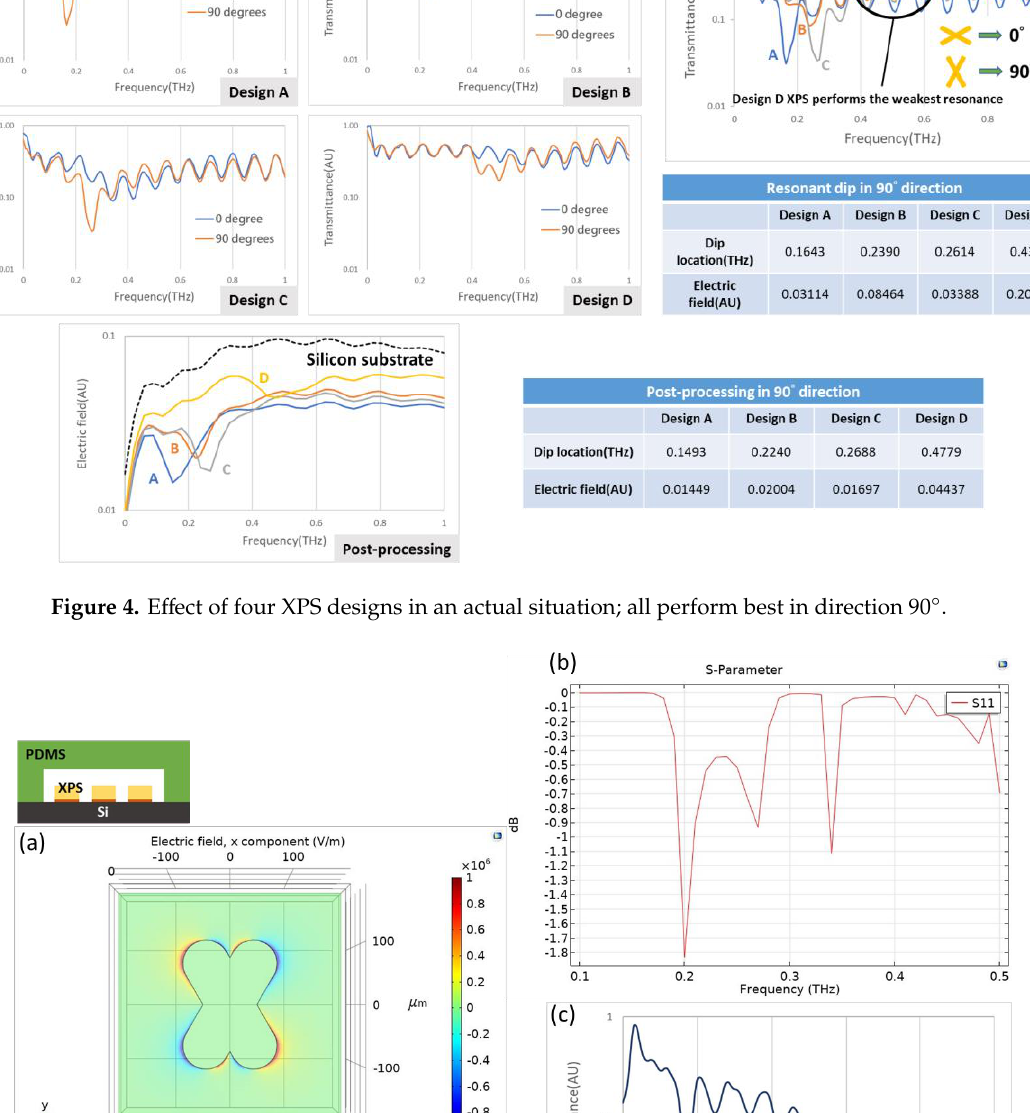
Figure 4. Effect of four XPS designs in an actual situation; all perform best in direction 90°.